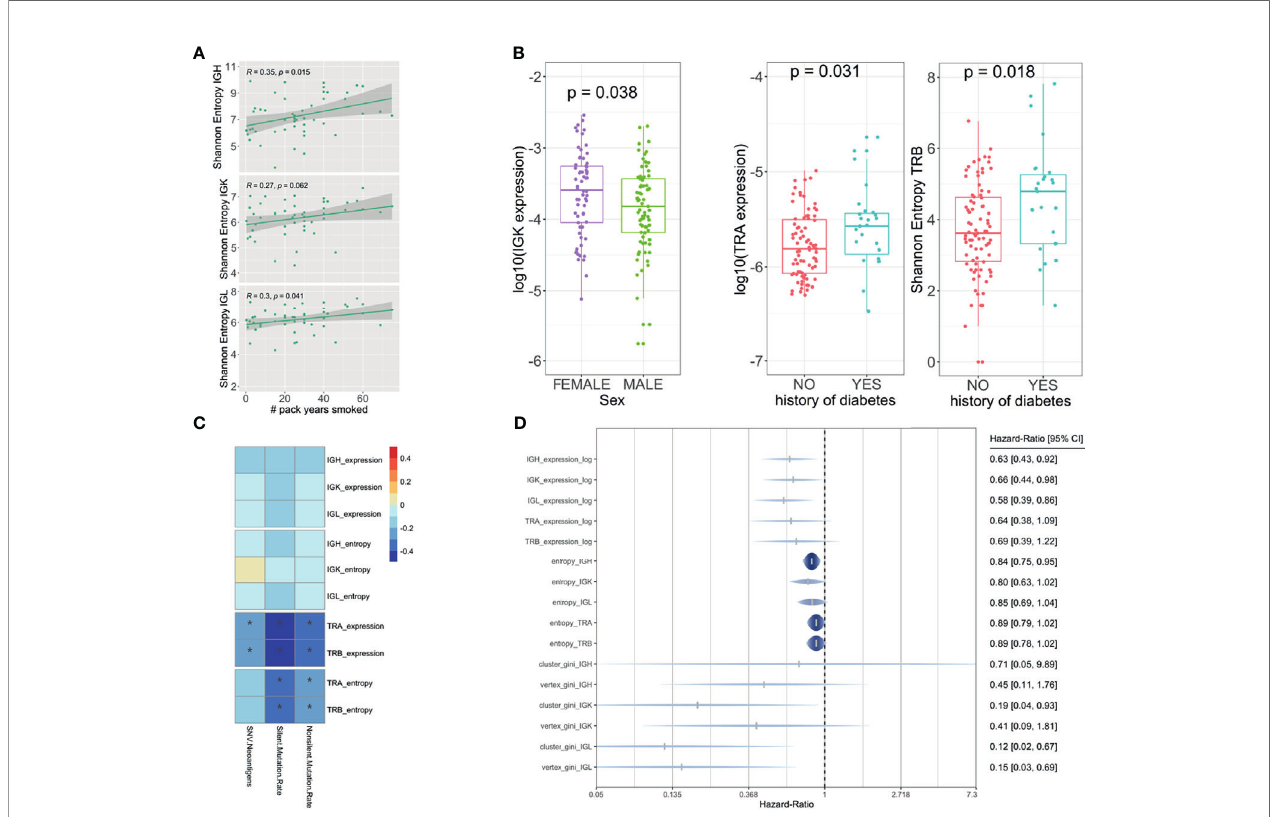
FIGURE 5 | Association analysis with clinical, demographic, mutational rate, and prognosis. Linear regression model showing the association between the IG and smoking (A) . Boxplot showing the association between TCR and diabetes and the association between IG and sex using a Wilcoxon test (B) . Pearson correlation showing the association between the TCR and IG with neoantigen load and mutational rate (C) . Forest plot showing the hazard ratios and 95% con fi dence intervals for the Cox regression (adjusted by age, sex, and pathological stage) of IG/TCR measures with overall survival (D) . The * shows if the correlation is signi fi cant (FDR <